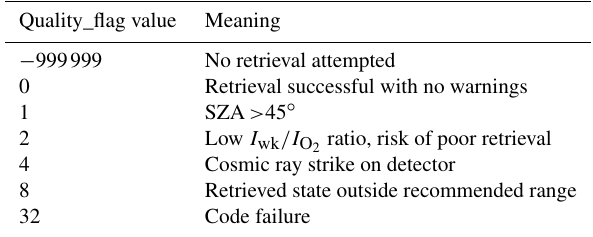
Table 3. Components of Quality_flag. If a retrieval is summed, then the final Quality_flag is the sum of all of these Quality_flag